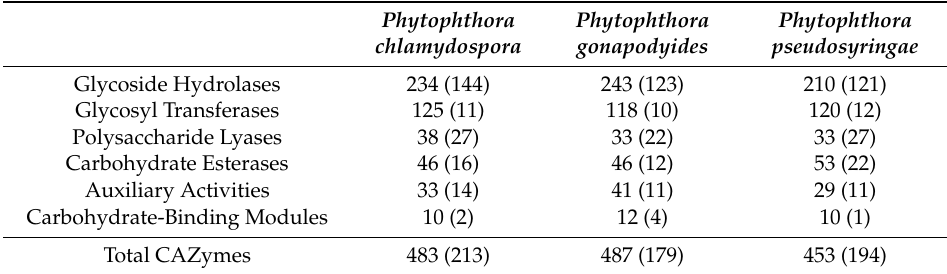
Table 4. Counts of carbohydrate-active enzymes (CAZymes) in Phytophthora genomes.